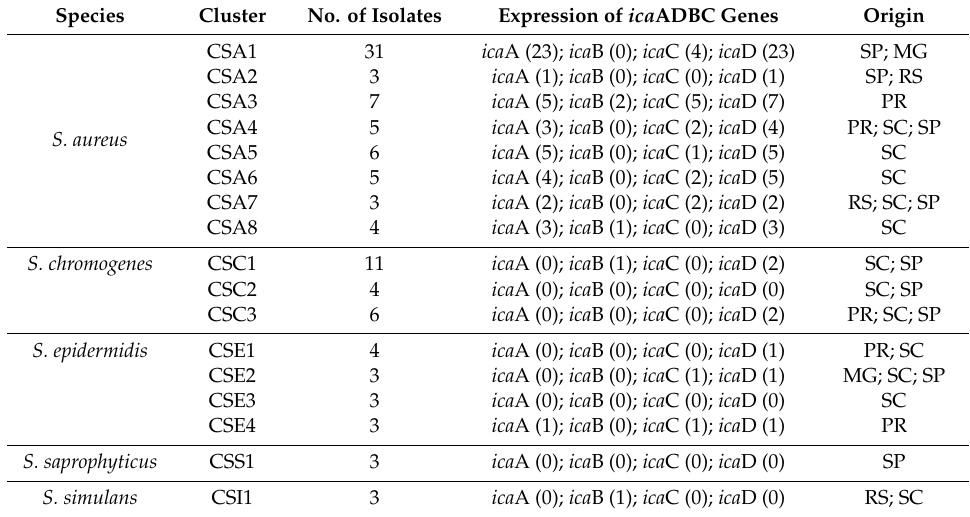
Figure 6. Dendrogram generated from the PFGE pattern of Staphylococcus simulans isolates (Dice similarity coefficient; clustering method: UPGMA). All Staphylococcus simulans isolates were negative for the bhp gene. Table 3. Electrophoretic pattern and expression of genes of the ica ADBC operon in Staphylococcus spp. clones isolated from bovine subclinical mastitis cases in different Brazilian states.